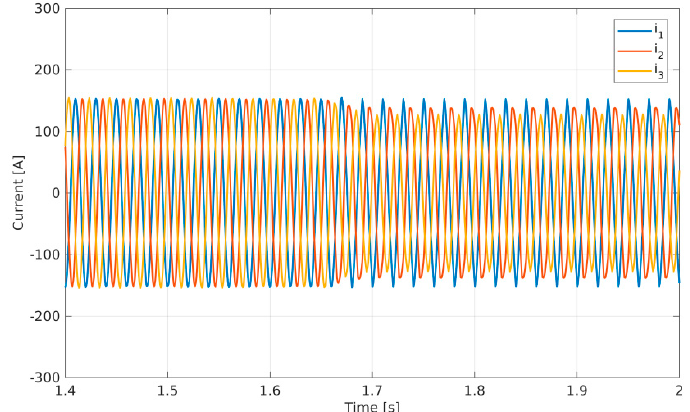
Figure 11. Voltage in the DC sides of the two inverters with a voltage sag of 70%.